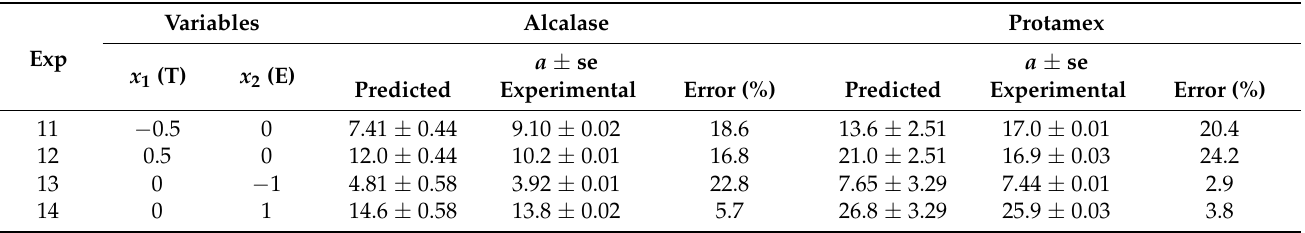
Table 6. Predicted and experimental values for kinetic constants a and b obtained from validation experiments with Alcalase and Protamex.